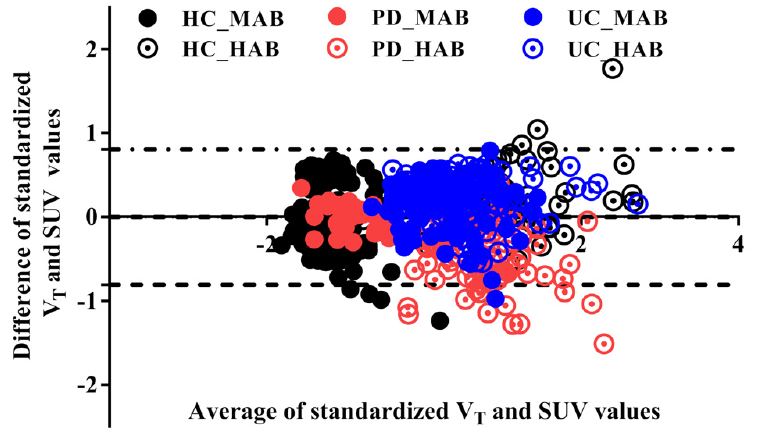
Figure 2. Bland–Altman plot of the standardized total distribution volume (V T ) and the standardized SUV. The standardized Logan V T is slightly higher than the standardized SUV outcome value ( − 0.004). The upper and lower limit agreements are − 0.8 and 0.8, respectively. A few genotype- and disease-independent ROIs overflow the limit bands because of the small size of the